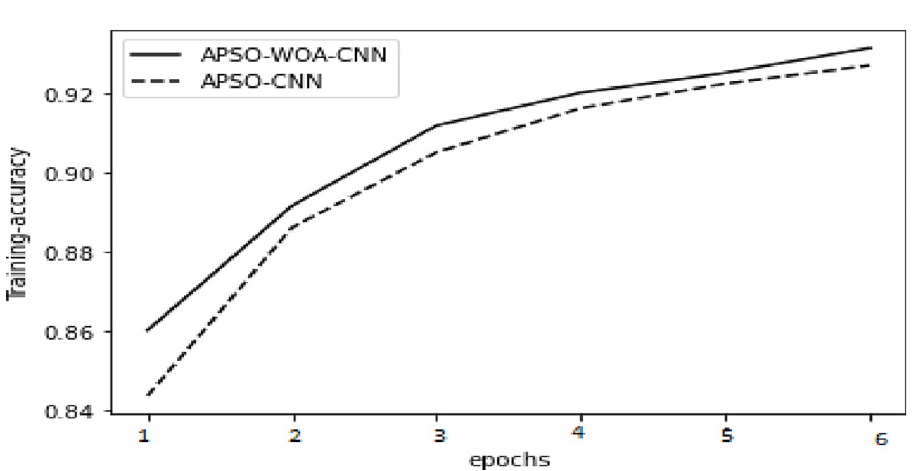
Fig 16. APSO–WOA–CNN and APSO–CNN algorithms’ accuracy training sets.